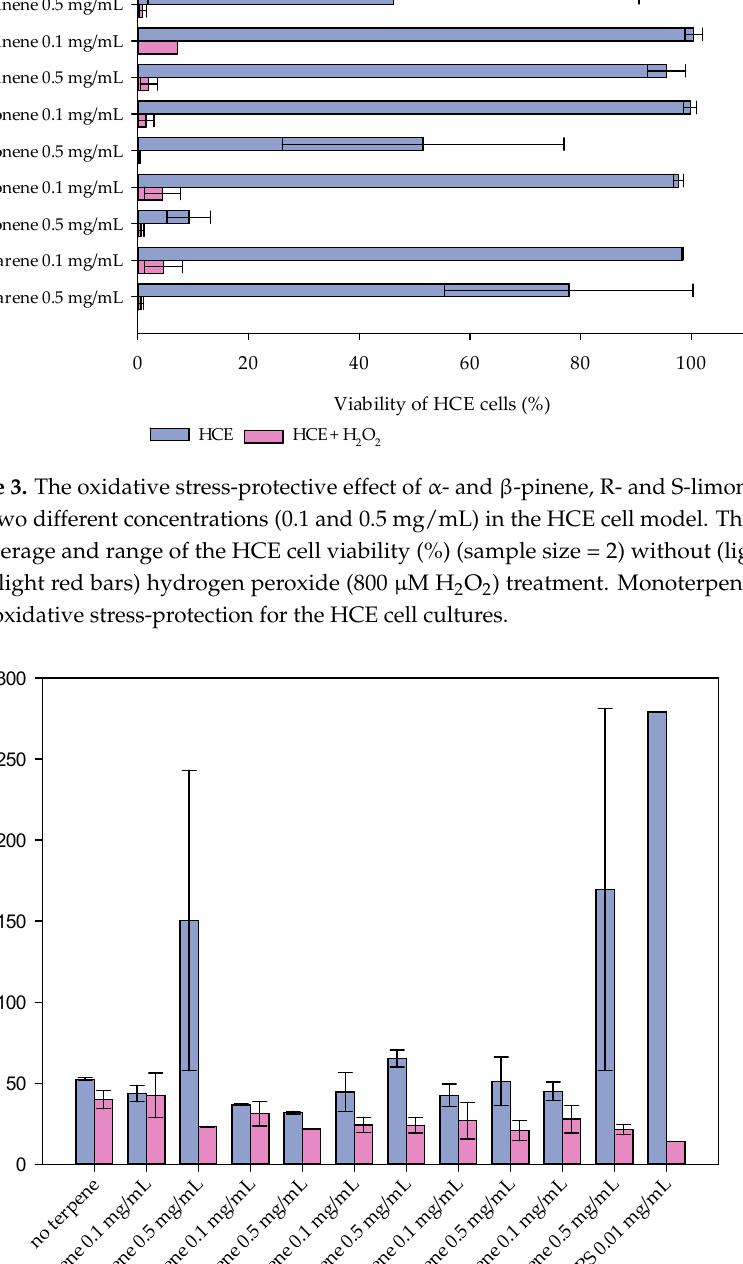
Figure 4. Inflammation marker protein (IL-6) was induced under 0.5 mg/mL α -pinene and 3-carene treatments. The values represent the average and range (sample size = 2) of IL-6 marker content (pg/mL) in the HCE cell cultures that were treated with 0.1 or 0.5 mg/mL α - or β -pinene, R- or S-limonene, or 3-carene without (light blue bars) and with H 2 O 2 treatment (light red bars). Lipopolysaccharide (LPS) was used as a positive control. Table 1. The half-maximal inhibitory concentration (IC50) of monoterpenes.